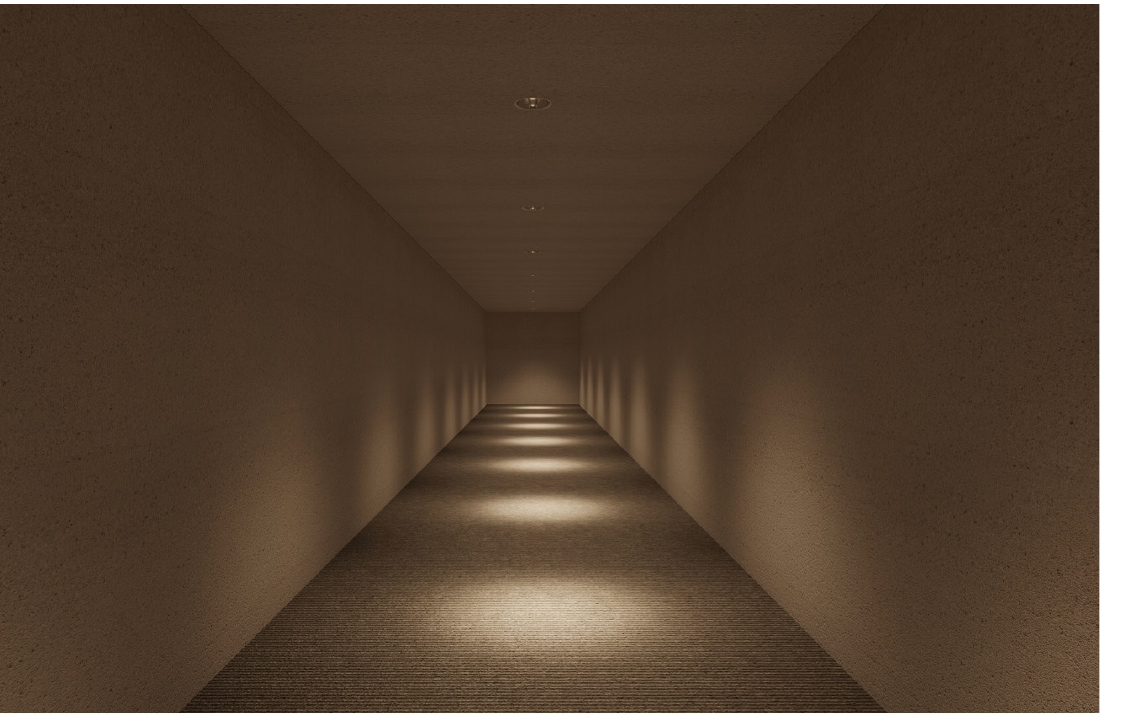
Figure 4. Computer simulation of corridor lighting for variant 1.